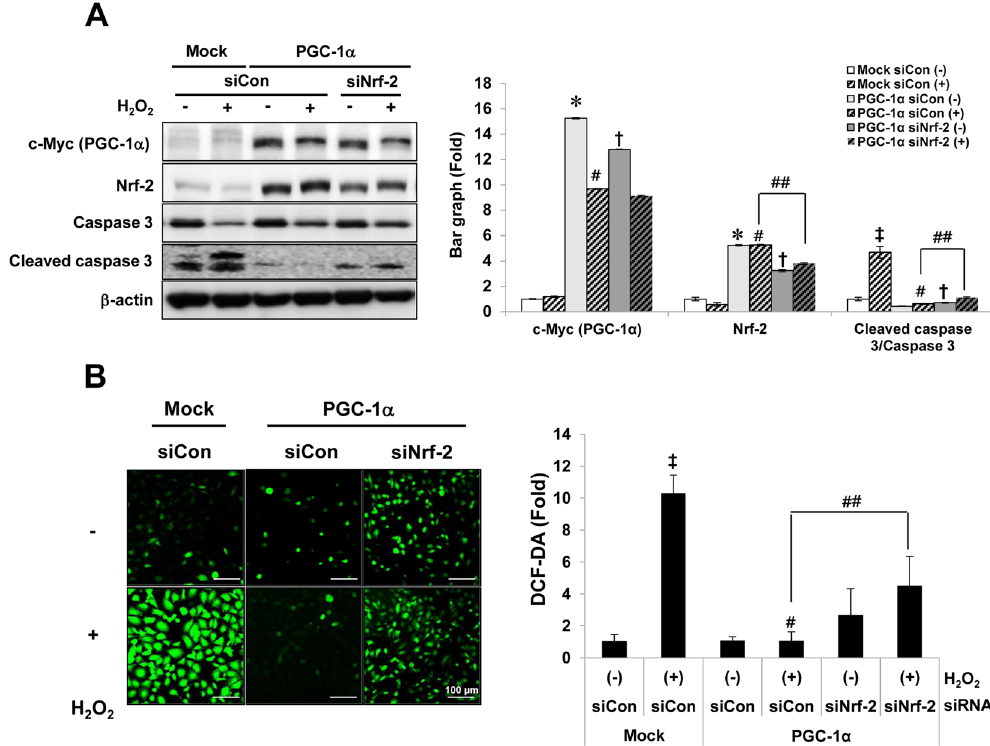
Figure 7. Nrf-2 specific-protective effects by PGC-1 α . To prove the dependence of Nrf-2 in anti-apoptotic and anti-oxidative effect of PGC-1 α , the level of activated caspase 3. Full-length blots of each tested protein are reported in Supplementary Figure S6 ( A ) and the level of DCF fluorescence ( B ) were assessed in Nrf-2 suppressed PGC-1 α cells under H levels were analyzed as internal controls. Error bars denote the mean ± S.D. of triplicate samples. * p < 0.05 siCon vs. siNrf-2 in PGC-1 α